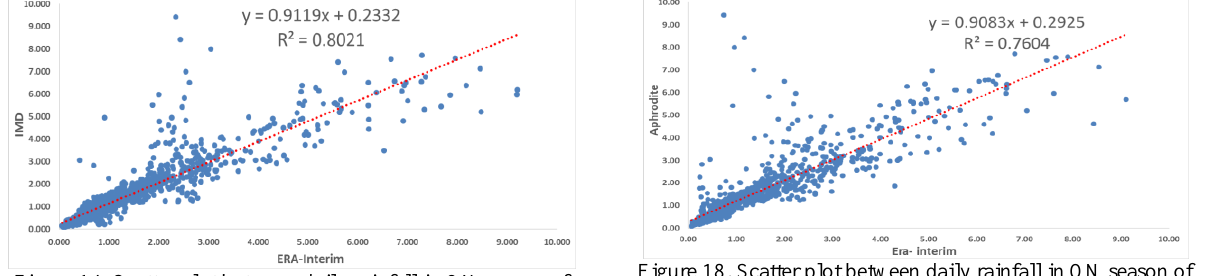
Figure 14. Scatter plot between daily rainfall in ON season of Era-Interim and IMD rainfall products